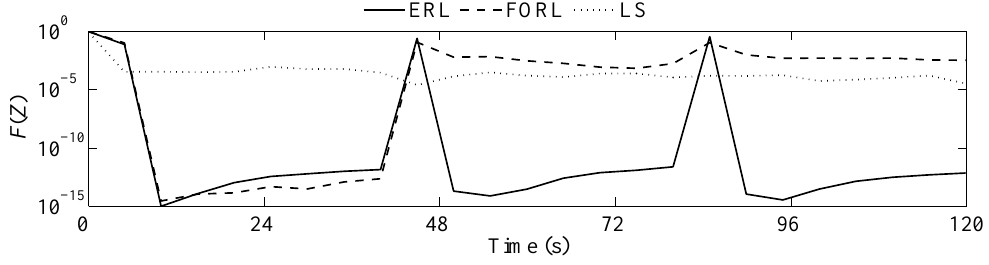
Figure 5. Objective function values obtained by the three